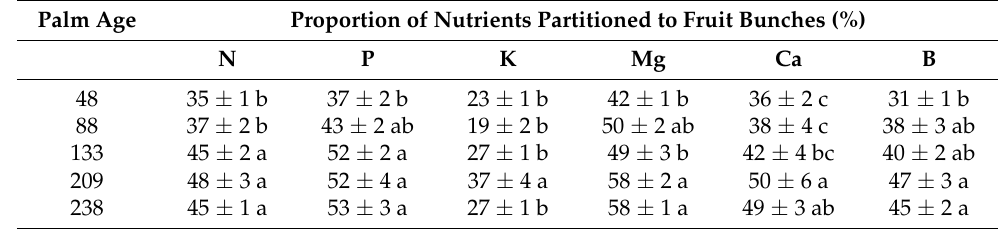
Table 10. Proportion of nutrients (mean ± SE) partitioned to fruit bunches in tenera oil palms of different ages. Palm age is given in number of months since nursery